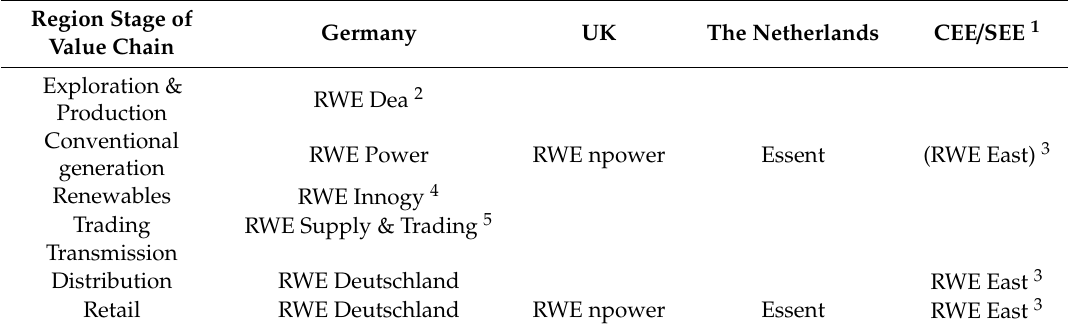
Figure A2. Activities of major RWE operational companies in the respective steps along the value chain. Own illustration, based on [24] (pp. 8–9) and [39]. Table A1. Activities of major RWE operational companies in the respective stages along the value chain and respective